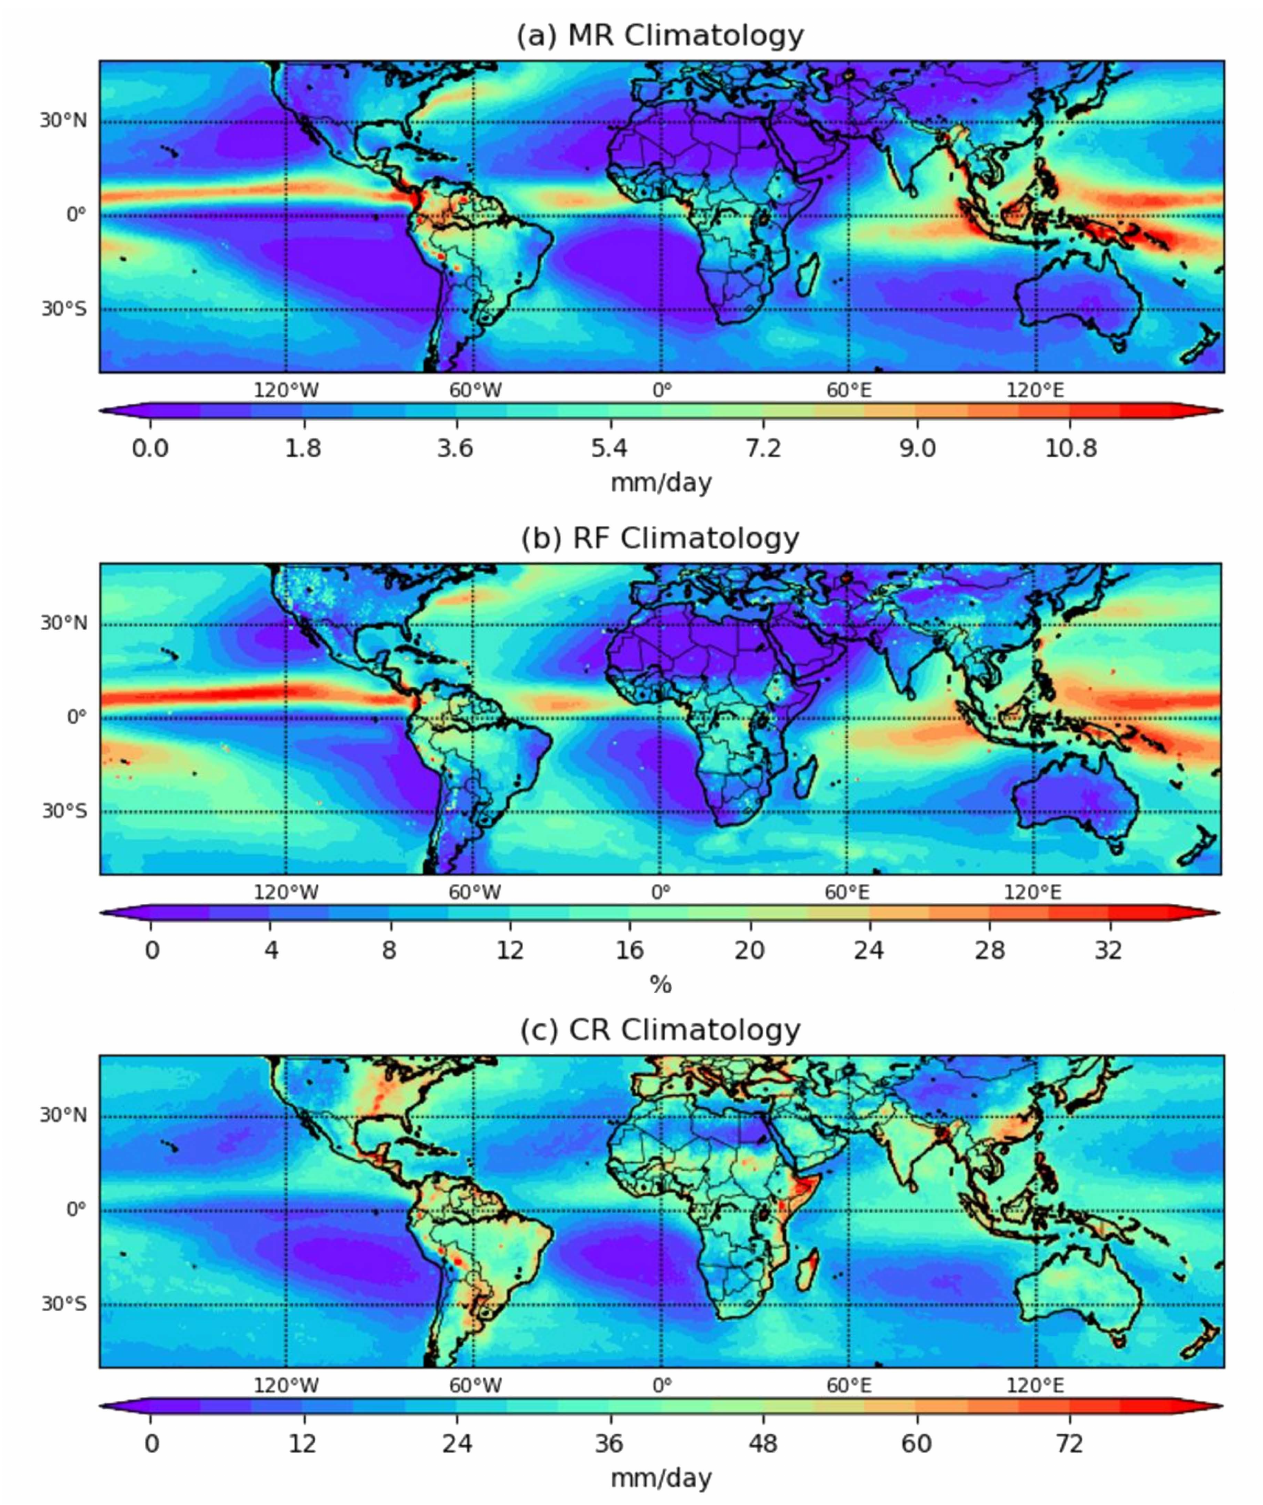
Figure 1. TMPA climatological (1998–2016) ( a ) mean precipitation rate (MR), ( b ) precipitation frequency (RF) and ( c ) precipitation intensity